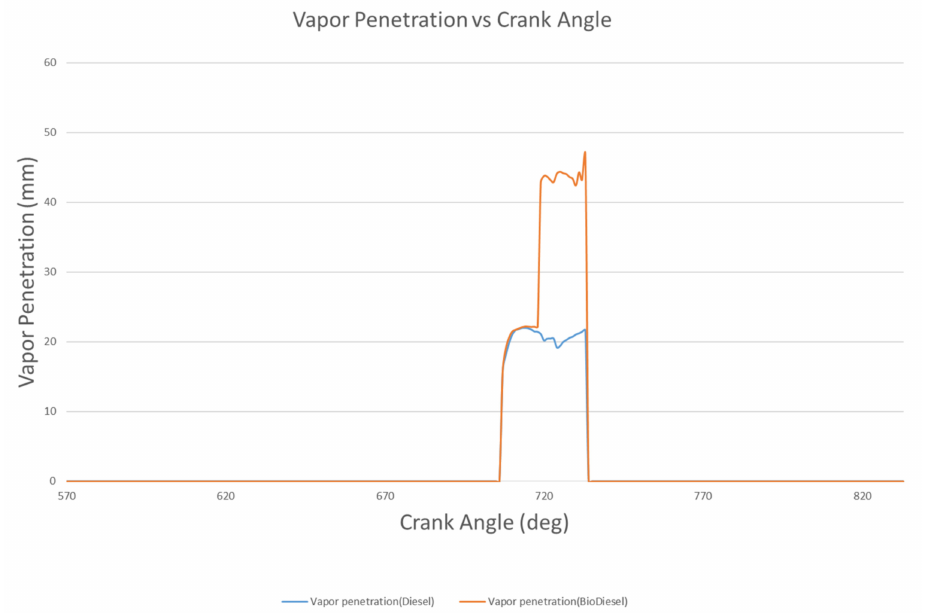
Figure 7. Vapor penetration length vs. crank